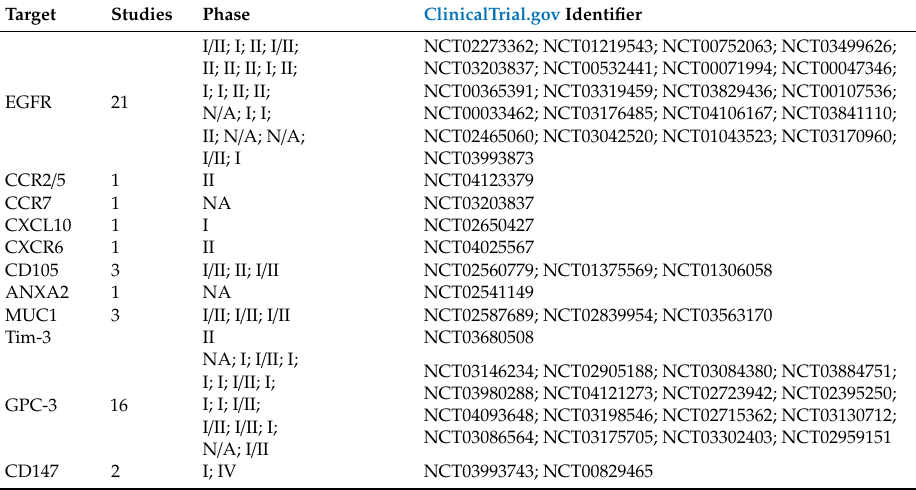
Figure 1. Schematic representation of cell surface receptors involved in hepatocarcinogenesis and HCC progression. EMT: epithelial–mesenchymal transition; ECM: extracellular matrix; HSC: hepatic stellate cells. Table 1. Summary of the clinical trials registered in ClinicalTrial.gov. N / A: not